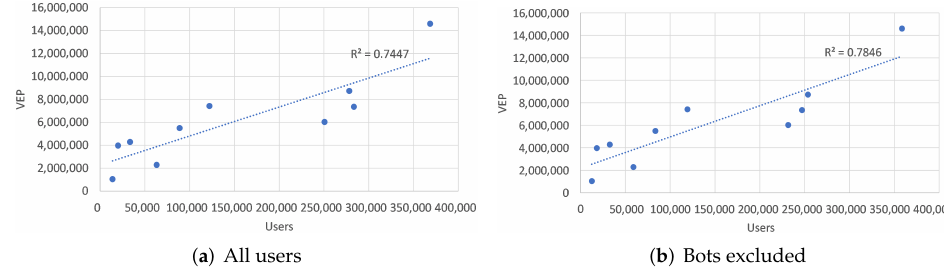
Figure 1. Linear interpolation: analyzed users vs. voting eligible population